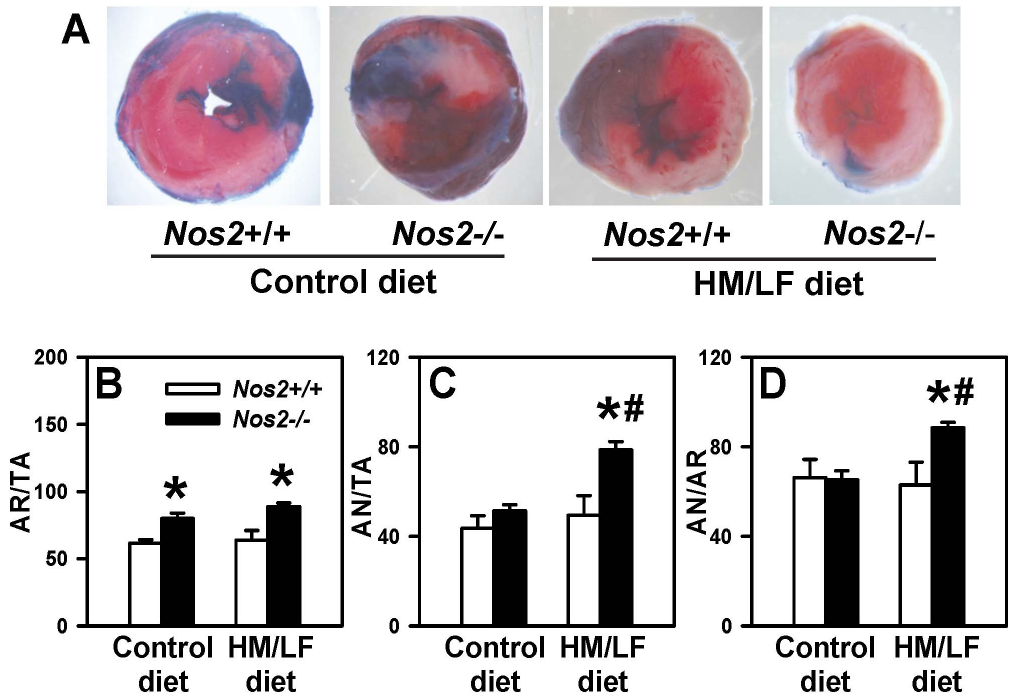
Figure 5. Regional myocardial ischemia-reperfusion injury. The left coronary artery was ligated for 30 minutes and then reperfused for 2 hours. Panel A illustrates representative 2,3,5-triphenyltetrazolium chloride (TTC) stained images for each of the four groups of mice. The percent of (B) area at risk over total area (AR/TA), (C) area of necrosis over total area (AN/TA), and (D) area of necrosis over area at risk (AN/AR) were calculated in Nos2 + / + (open bars) or Nos2 2 / 2 mice (filled bars) by staining with Evans blue and TTC. Values are mean 6 SE. 8–12 mice were studied in each group. *P , 0.01 compared with Nos2 + / + mice fed the same diet, # P , 0.05 compared with mice of the same genotype fed the control diet by two-way